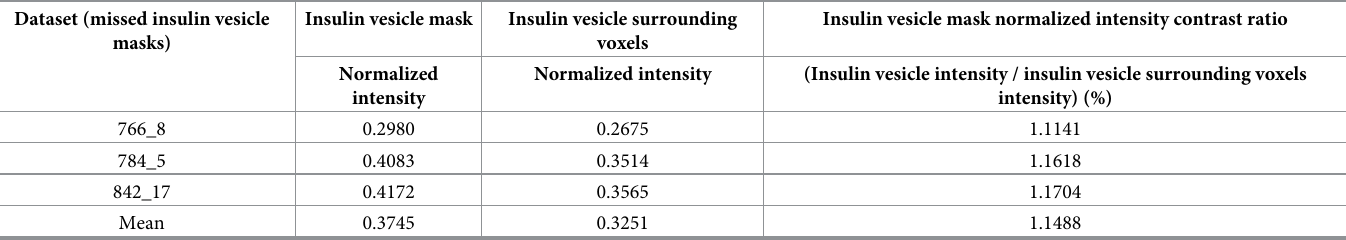
Missed insulin vesicles were calculated by matching manual segmented instances to auto-segmented instances, and unmatched instances from the manual segmented results we classified as the missed insulin